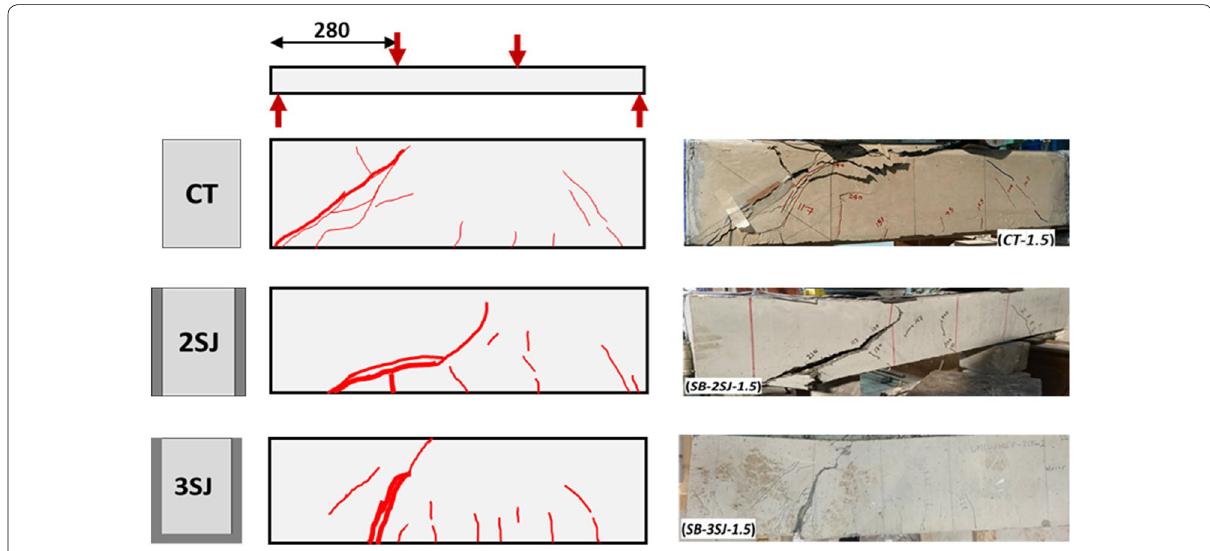
Fig. 12 Crack patterns of beams with a / d